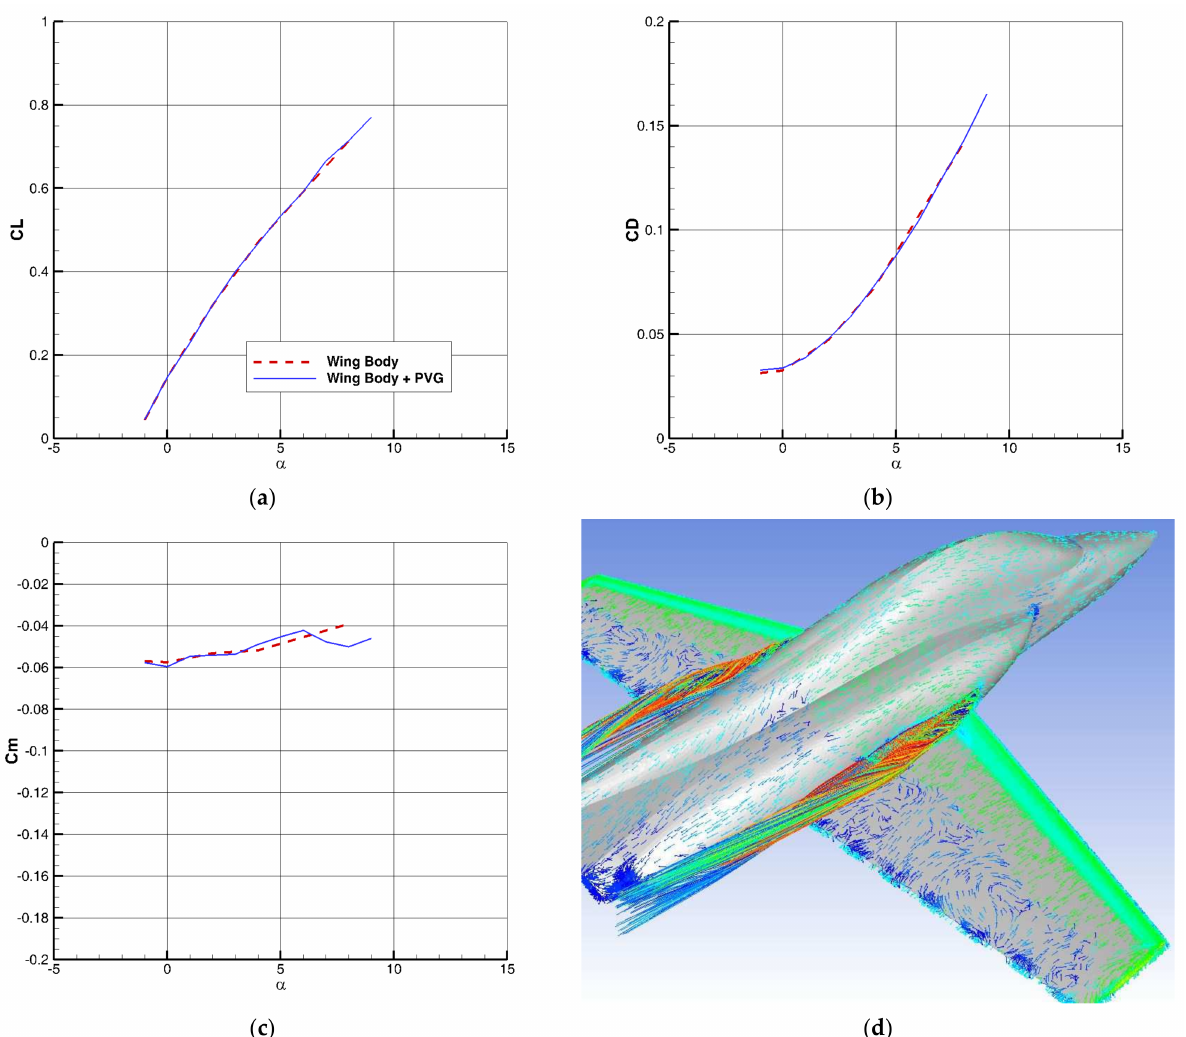
Figure 12. Effect of PVG on the clean configuration of the wing-body in M = 0.87, h = 30,000 ft: ( a ) C L − α diagram; ( b ) C D − α diagram; ( c ) C m − α diagram; ( d ) the path lines of PVG and wing- body vectors at α = 8 ◦